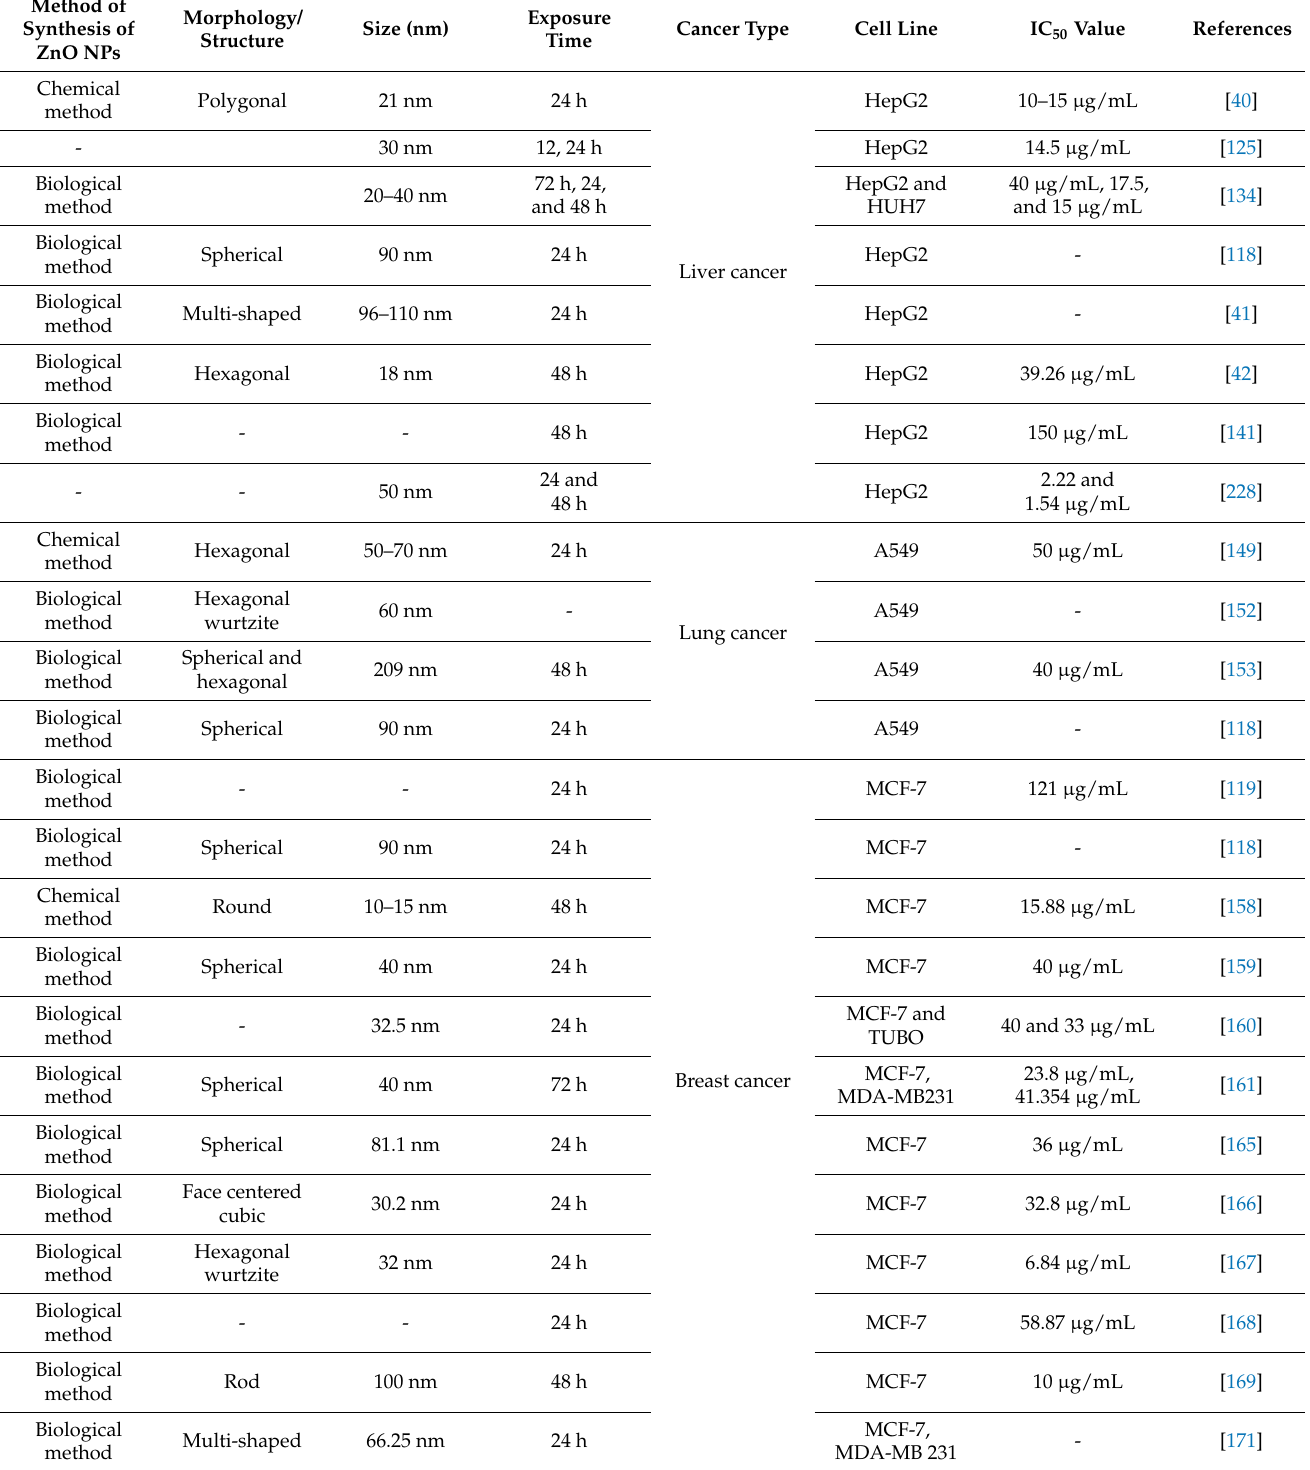
Table 2. Anticancerous activity of ZnO NPs on different types of cancer cell